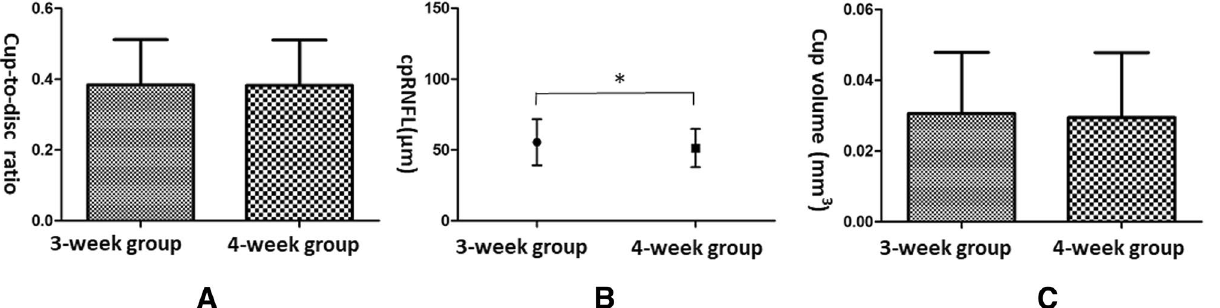
Figure 2. Morphological parameters of the optic nerve head in normal guinea pigs. ( A ) Cup-to-disc ratio: 0.38 ± 0.128 (3-week group) and 0.38 ± 0.128 (4-week group). ( B ) Thickness of circumpapillary retinal nerve fibre layer: 55.4 ± 16.27 μm (3-week group) and 51.3 ± 13.45 μm (4-week group). ( C ) Cup volume: 0.031 ± 0.0173 mm 3 (3-week group) and 0.029 ± 0.0184 mm 3 (4-week group). *p <